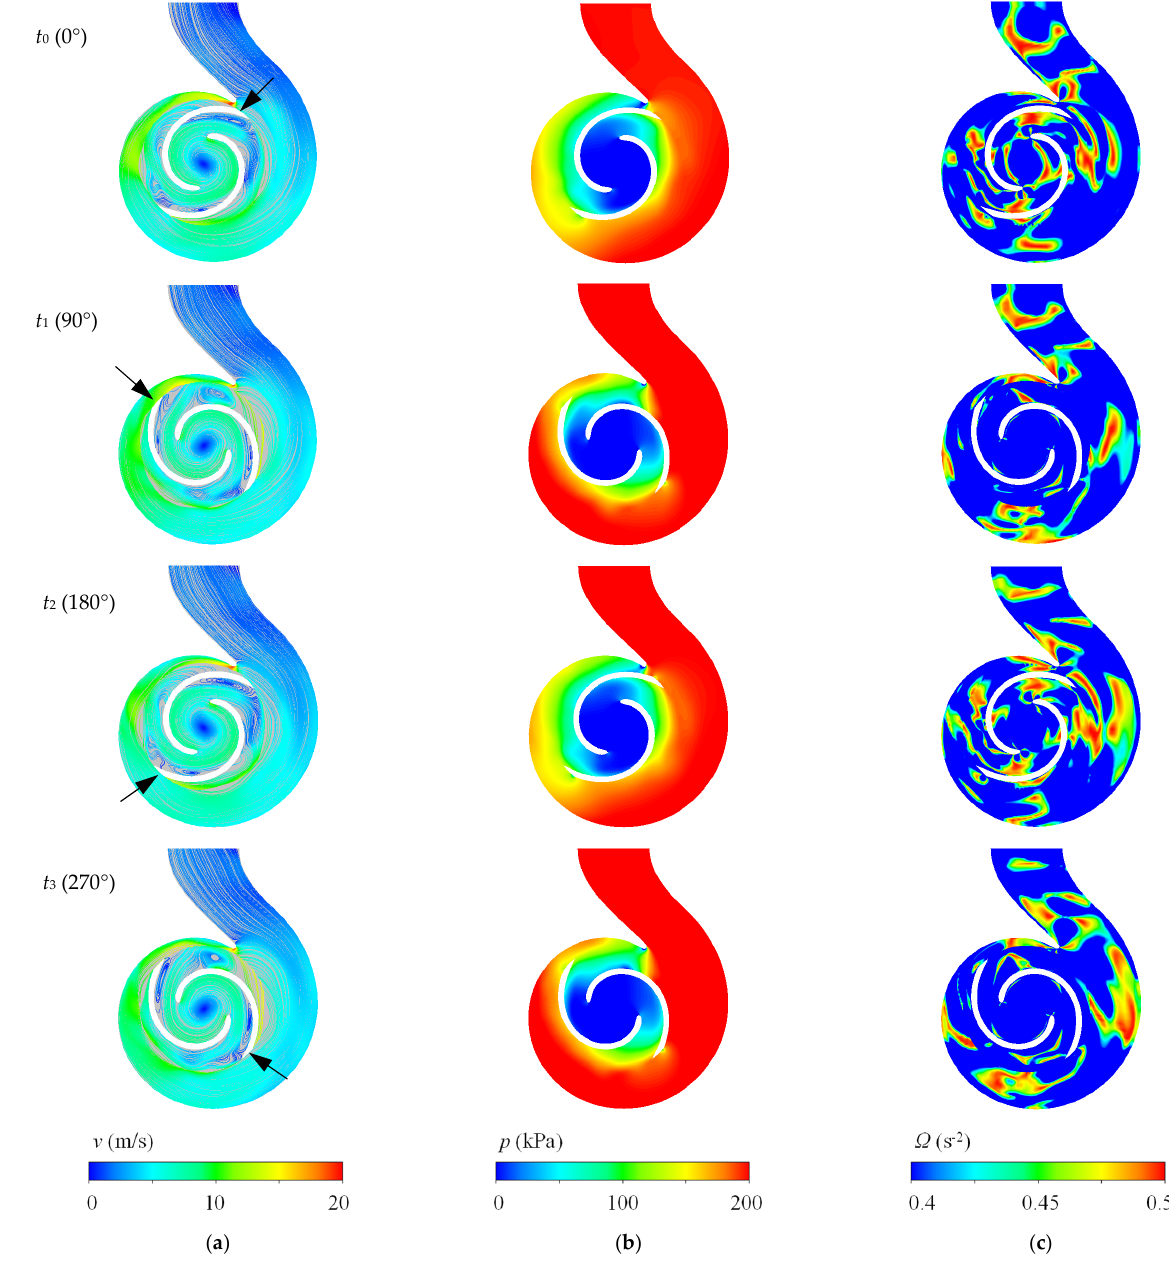
Figure 11. Instantaneous flow field at mid-span of pump under low flow rate 0.4 Q d : ( a ) streamlines of relative flow velocity; ( b ) static pressure distribution; ( c ) vorticity distribution.